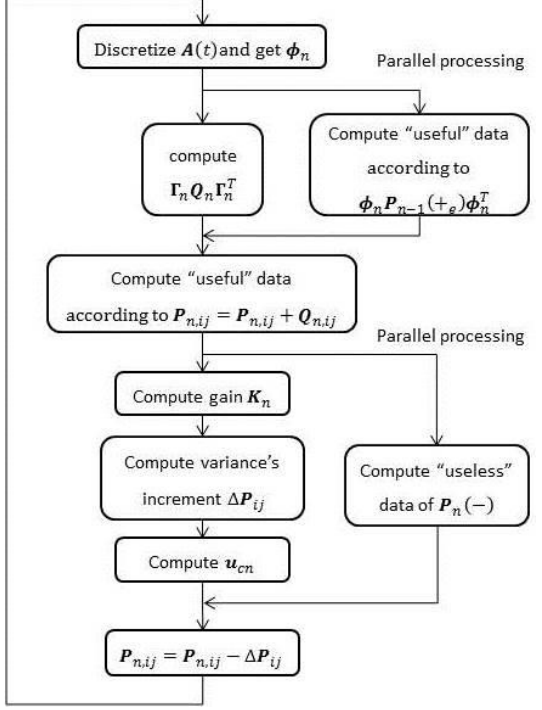
Figure 2. Filtering process with parallel